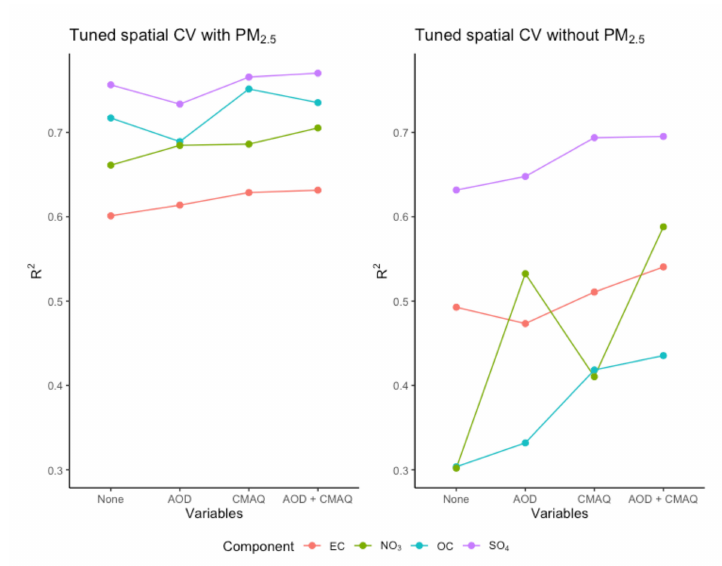
Figure 1. R 2 of spatial cross-validation (CV) results for predicting PM 2.5 components elemental carbon (EC), organic carbon (OC), sulfate (SO 4 ), and nitrate (NO 3 ), comparing the inclusion of only Multi-Angle Imaging Spectroradiometer (MISR) fraction AOD, only CMAQ simulations, or both AOD and CMAQ. All models contain meteorology and land-use variables.